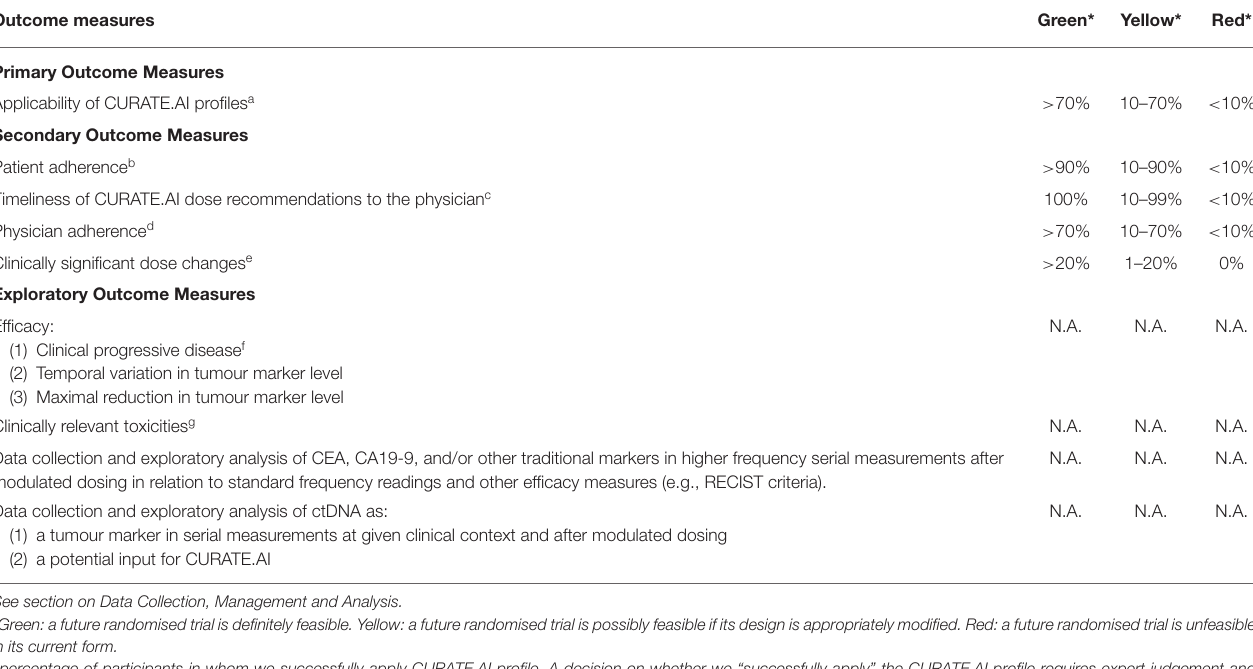
PRECISE CURATE.AI Pilot Clinical Trial